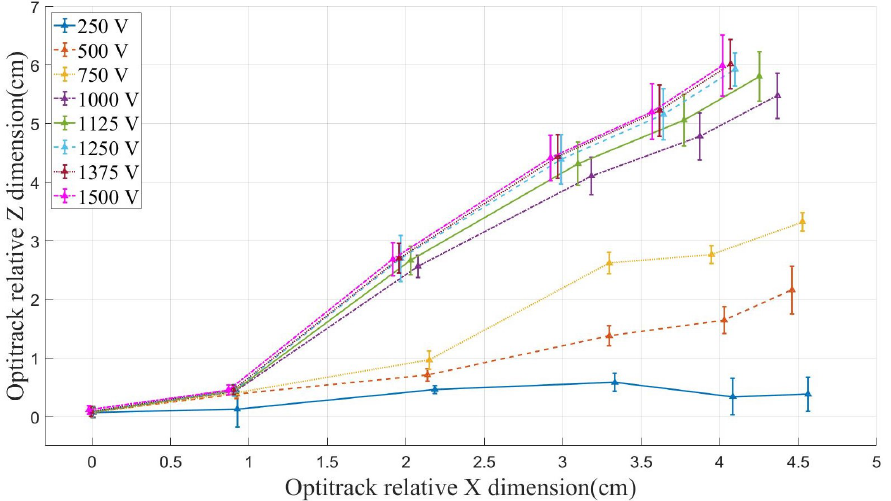
Figure 14. Tail raise repeatability experiments: Lateral view.